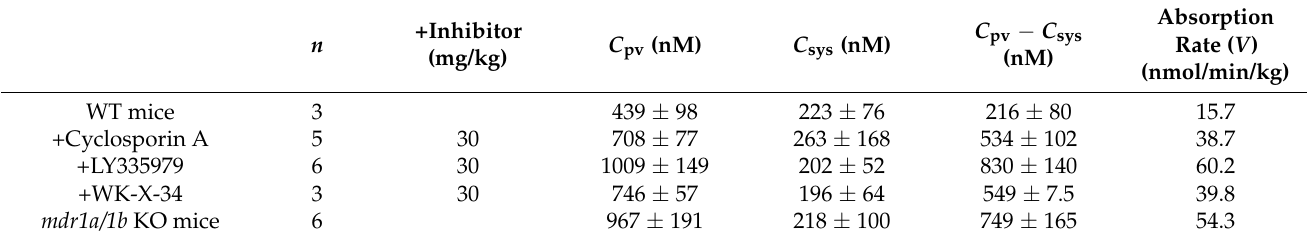
Table 4. Absorption rate of paclitaxel (10 mg/kg) at 10 min after its oral administration with or without P-gp inhibitors in WT and mdr1a/1b KO mice.